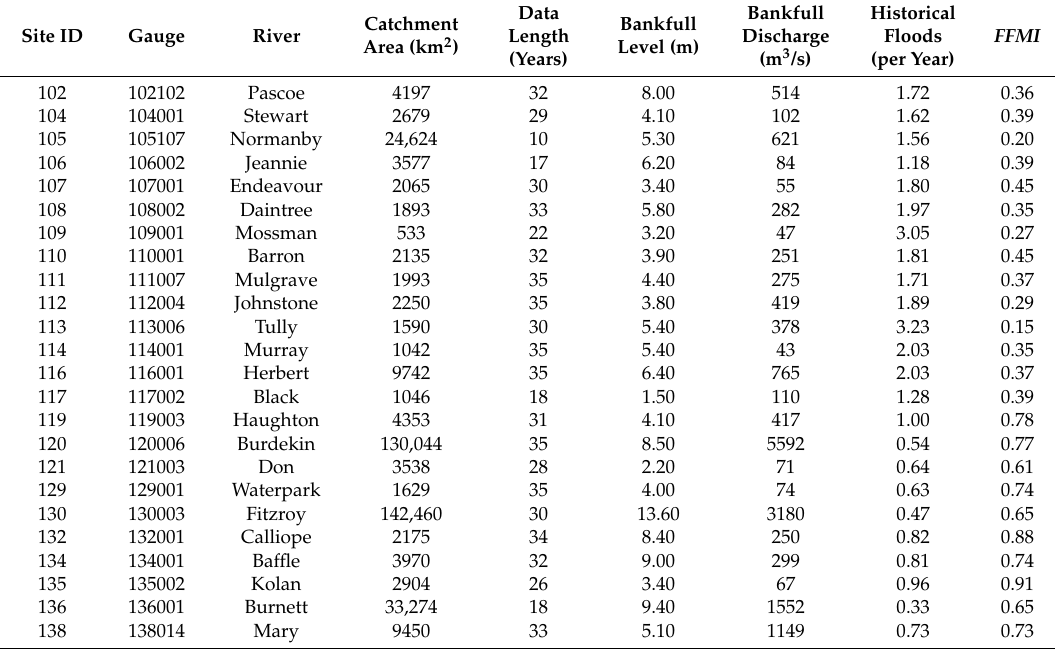
Table 2. Frequencies of historical floods and flash flood magnitude index ( FFMI ) for the GBR